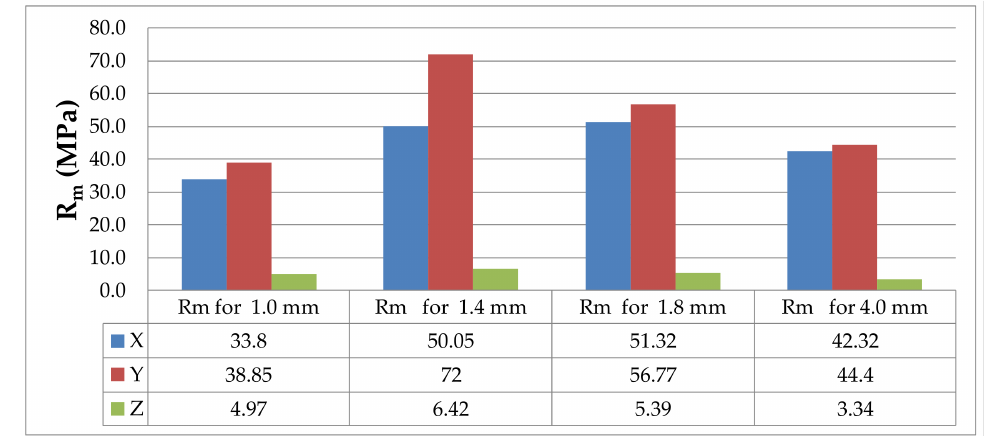
Figure 23. Ultimate tensile strength R m for PLA-CF specimens differing in thickness and print direction, where X, Y and Z are printing